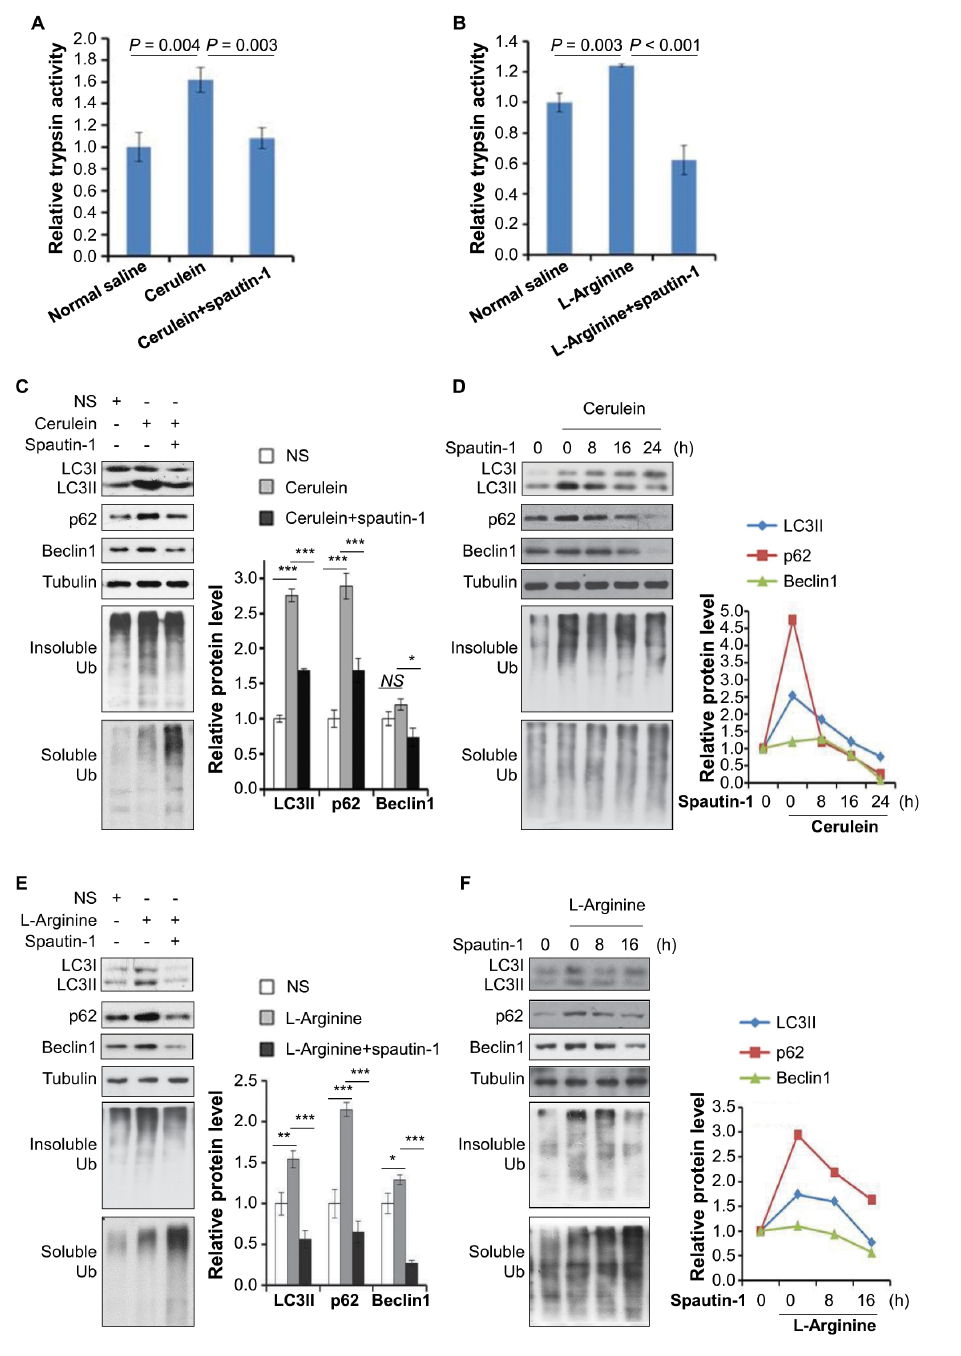
Figure 2. Spautin-1 reduces impaired autophagy and inhibited trypsinogen activation in pancreatic acinar cells with cerulein or L- arginine treatment. (A, B) AR42J cells were treated with normal saline (NS), 200 nmol/L cerulein (A) or 10 mmol/L L-arginine (B) in the presence or absence of 10 μ mol/L spautin-1 for 24 h. The trypsin activity was next analyzed by the fluorescence intensity. Data from three independent experiments were tested Student t test and shown as means ± SD. (C–F) AR42J cells with indicated treatment were lysed and were analyzed by Western blotting with anti-LC3, anti-p62, antibeclin1, Ub and antitubulin antibodies. The relative levels of LC3II, p62 and beclin1 expression were are quantified using Image J and exhibited as the bar graphs from three independent sets of experiments (C, E) and line graphs from two independent sets of experiments (D, F). Error bars represent SD. Student t test was used *P < 0.05, ** P < 0.01, *** P <